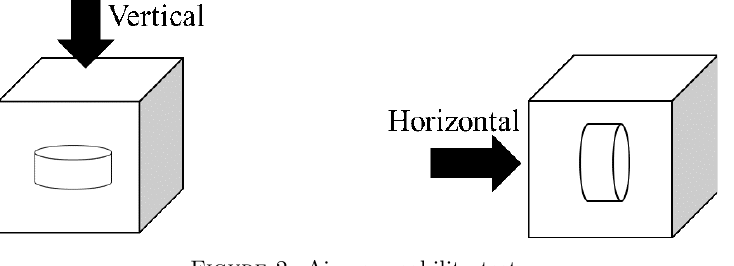
Figure 2. Air permeability test.